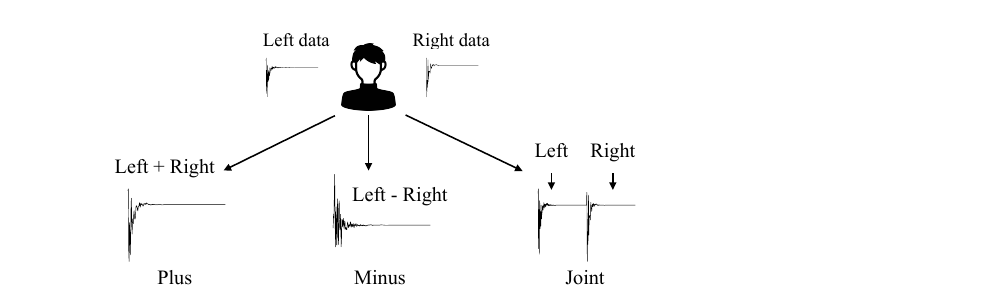
Figure 8. Feature extraction method for bilateral ear data. Plus is a method of adding data to the left ear and the right ear. Minus is a method of subtracting data from the left and right ear. Joint is a method for concatenating data from the left and right ears.